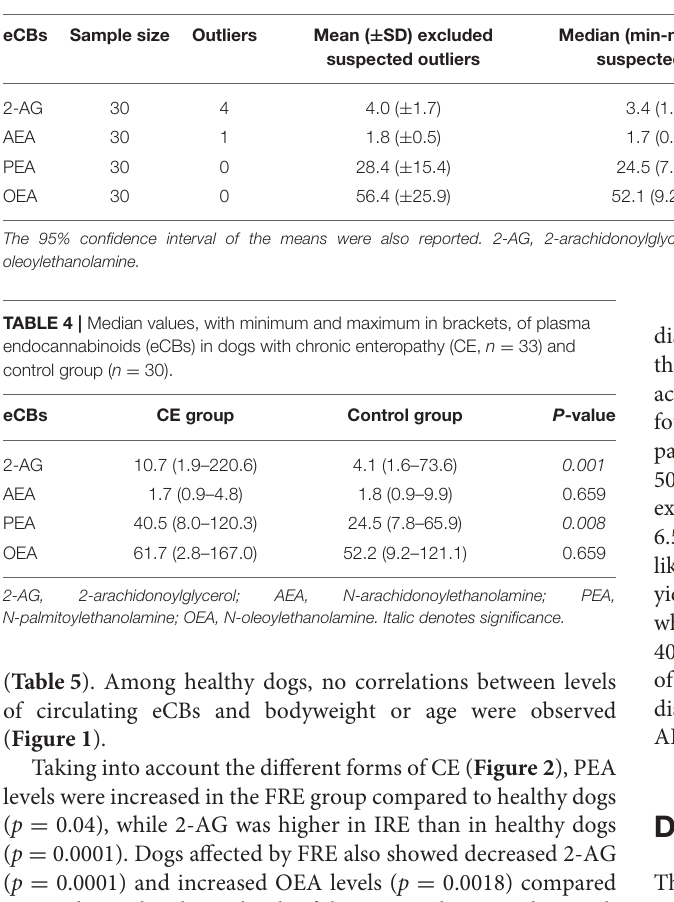
TABLE 3 | Mean with standard deviation (SD) and median with minimum and maximum (min-max) of healthy dogs excluded suspected outliers. eCBs Sample size Outliers